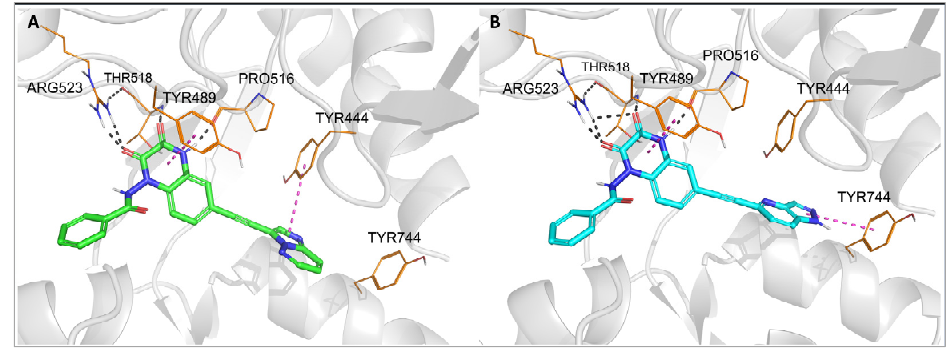
Figure 3. Top-ranked docking poses of 28 ( A ) and 29 ( B ) in the GluK1-LBD (PDB code: 6SBT). Hydrogen bonds are marked with gray dashes, π – π interactions are marked with pink dashes.